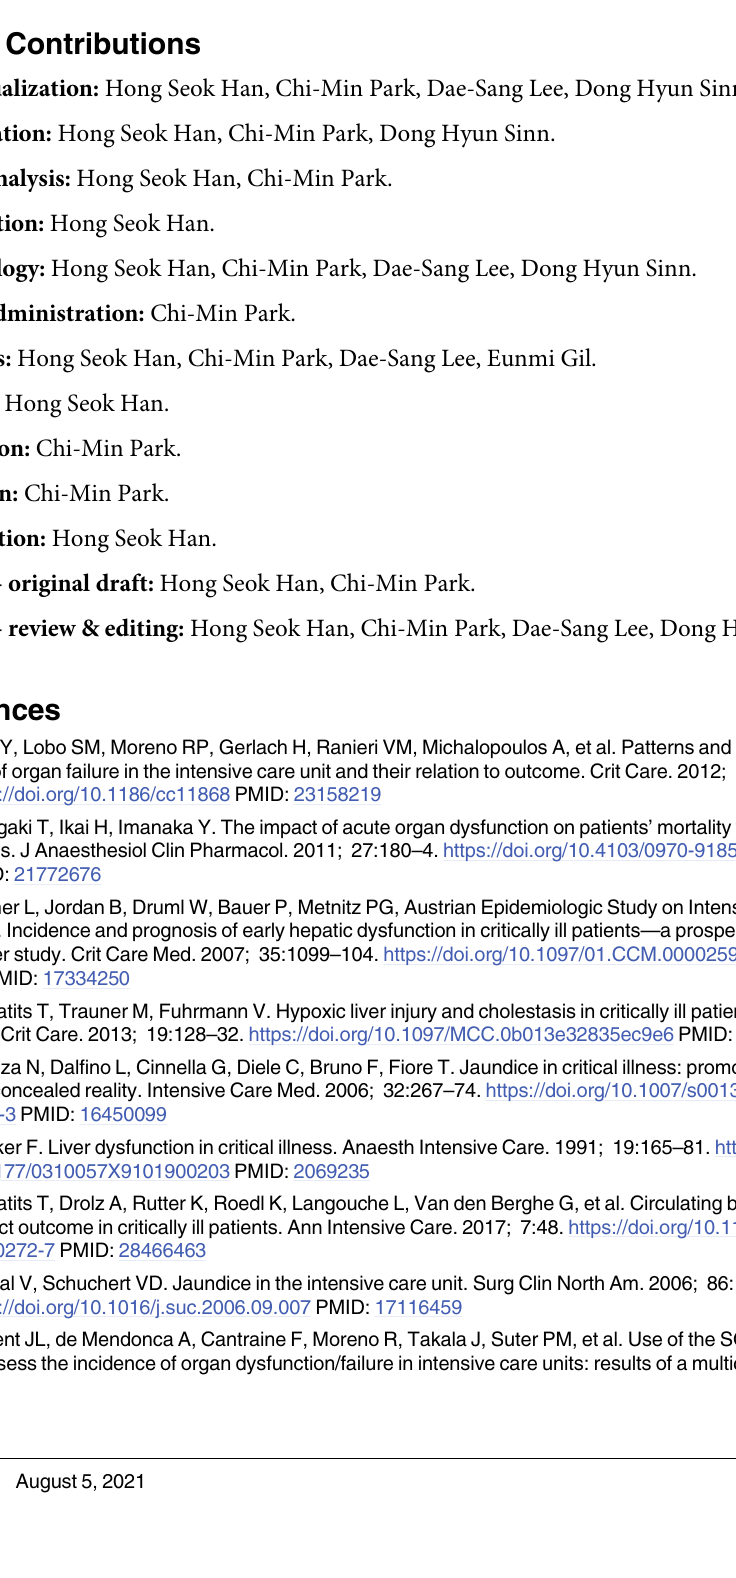
S1 Fig. The selection process of the study population for extreme hyperbilirubinemia. (TIF) S1 Dataset.